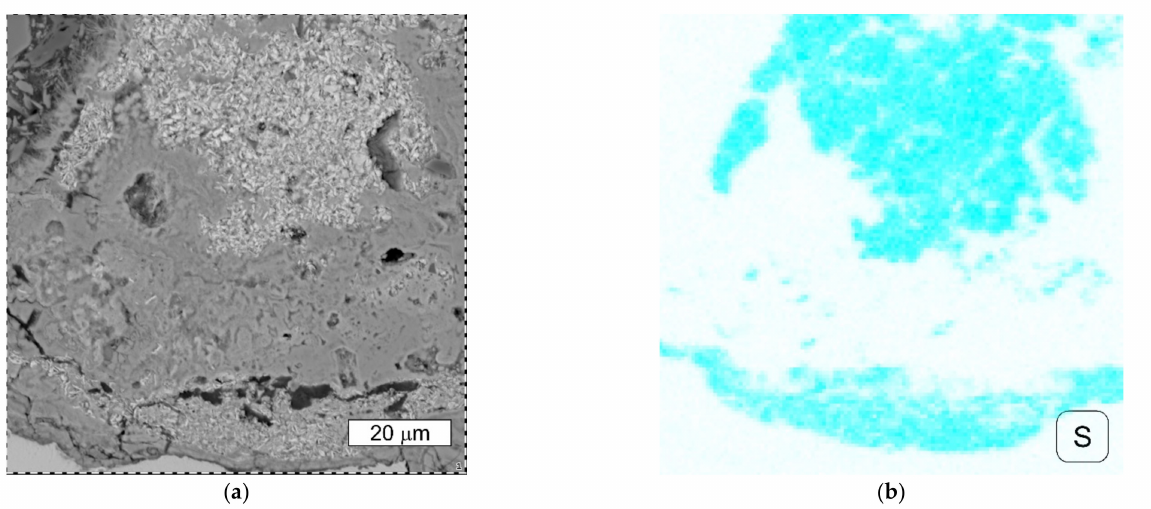
Figure 18. ( a ) SEM image of the deposit observed on the cross-section of the S1 bolt thread surface. An enlarged area from Figure 17a, BSD ( b ) Distributions of sulphur obtained in the mapping performed at the area presented,